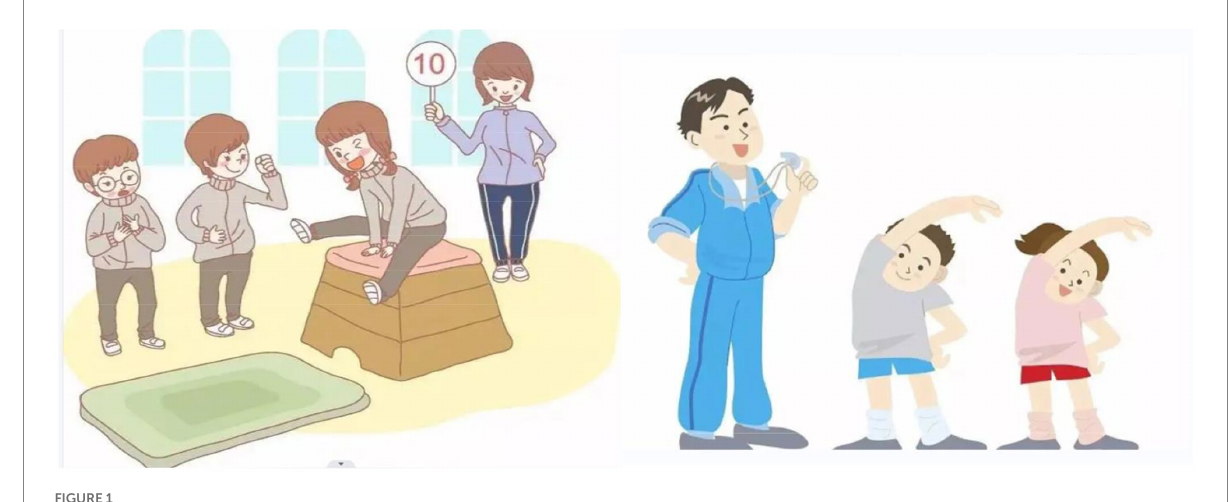
FIGURE 1 Physical education in colleges and